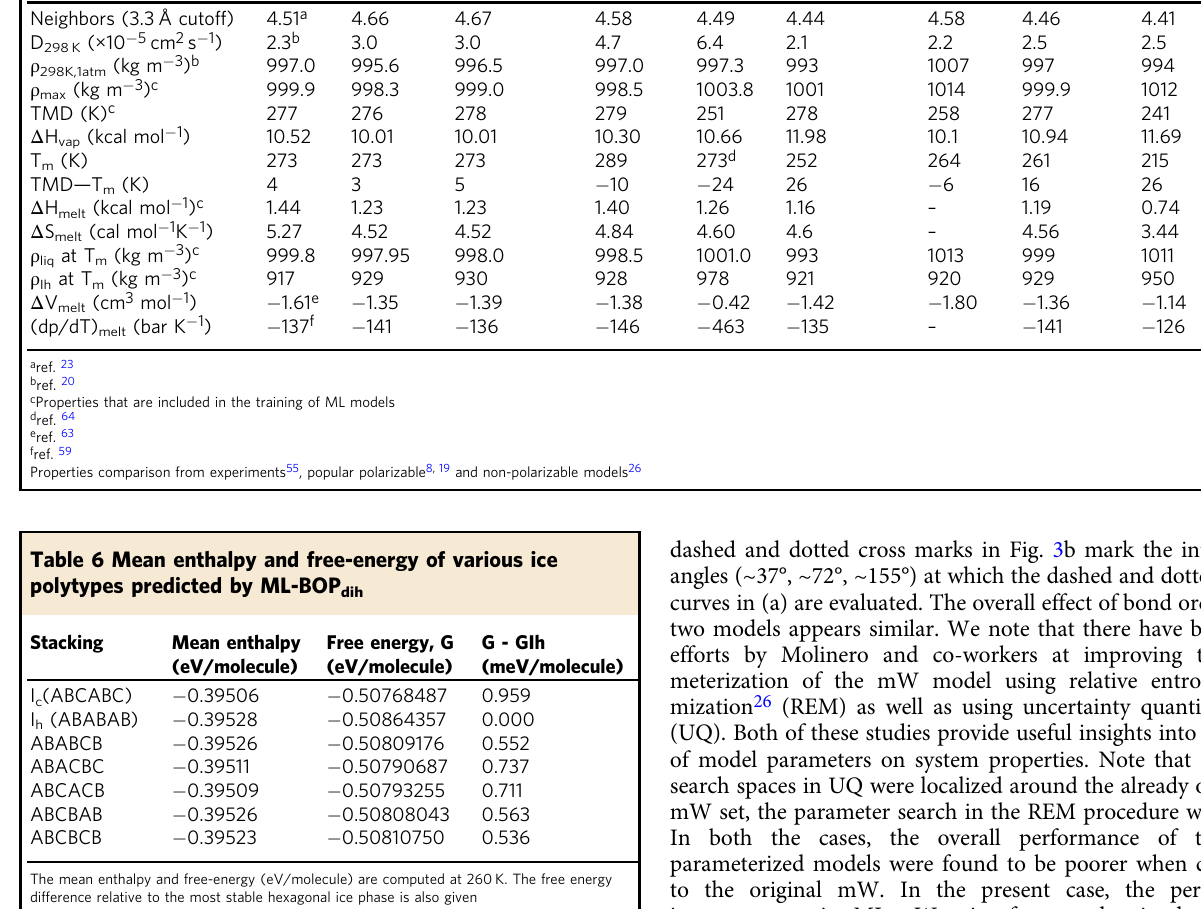
Table 5 Properties of ML models compared to experiments and other popular water models Exp